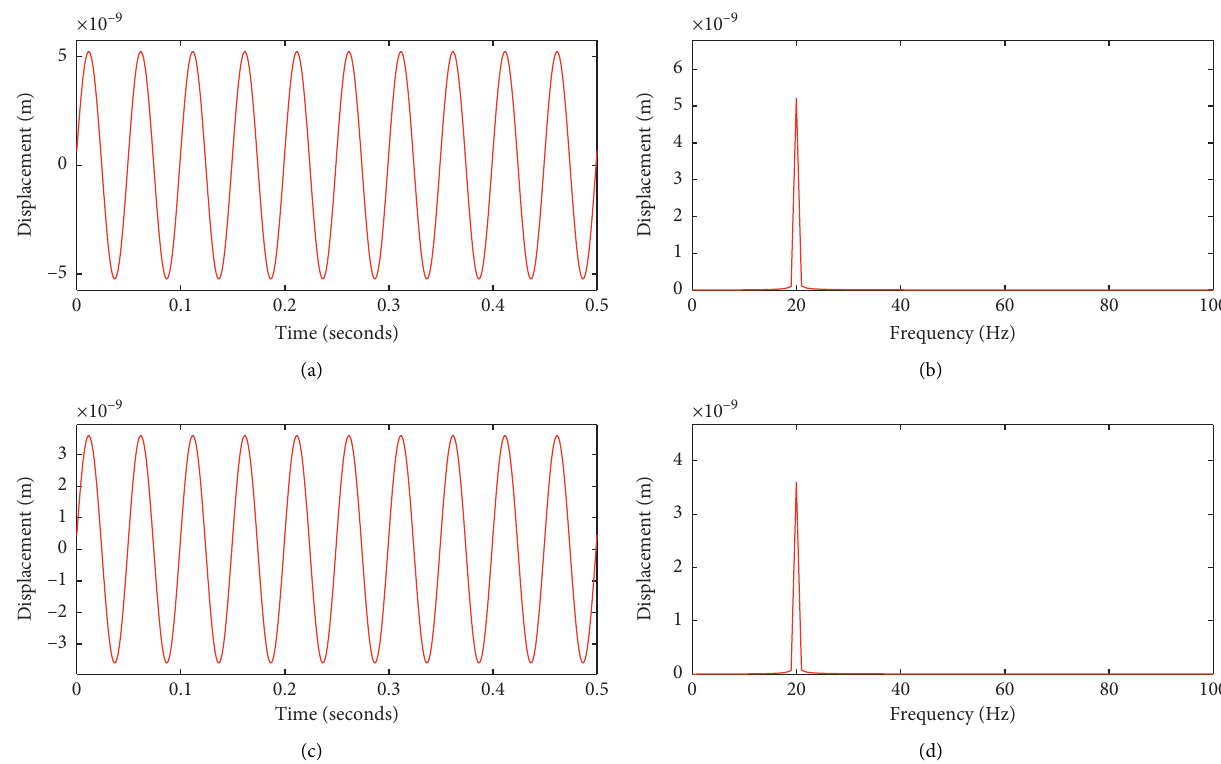
Figure 8: Response of the time and frequency domains to an imbalance in the x direction. (a) Time response of x1. (b) Frequency response of x1. (c) Time response of x2. (d) Frequency response of x2.